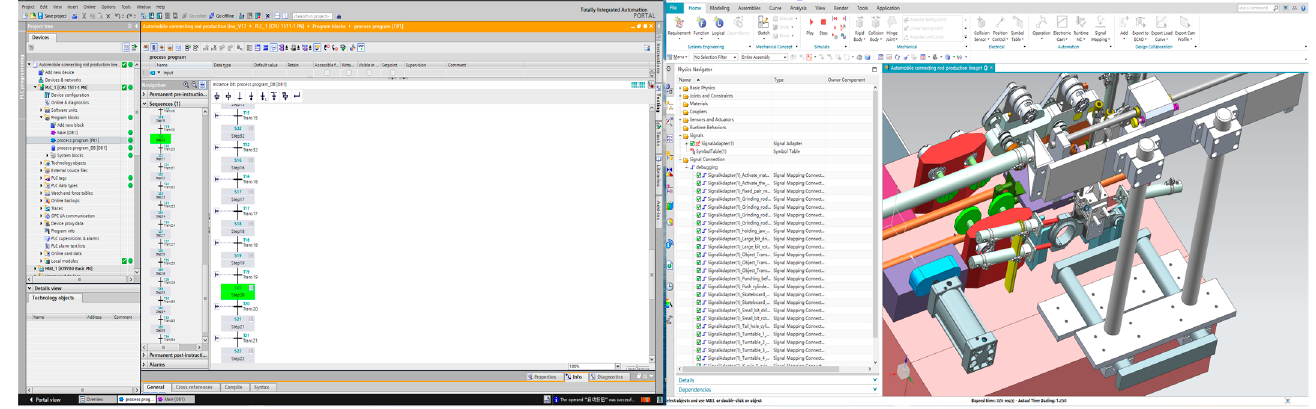
Figure 20. Real-time debugging of bolt-hole processing.